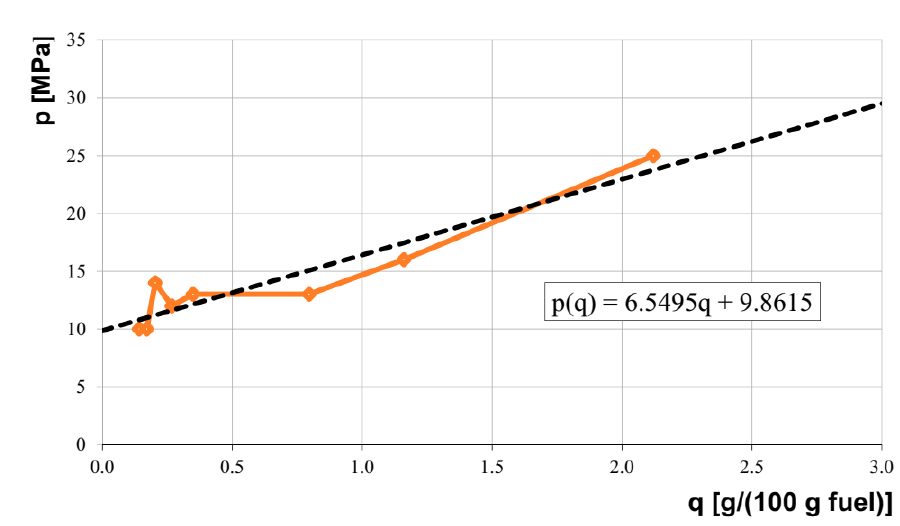
Figure 3. Minimum pressure level necessary for complete dissolution of air (the equation describes the trend